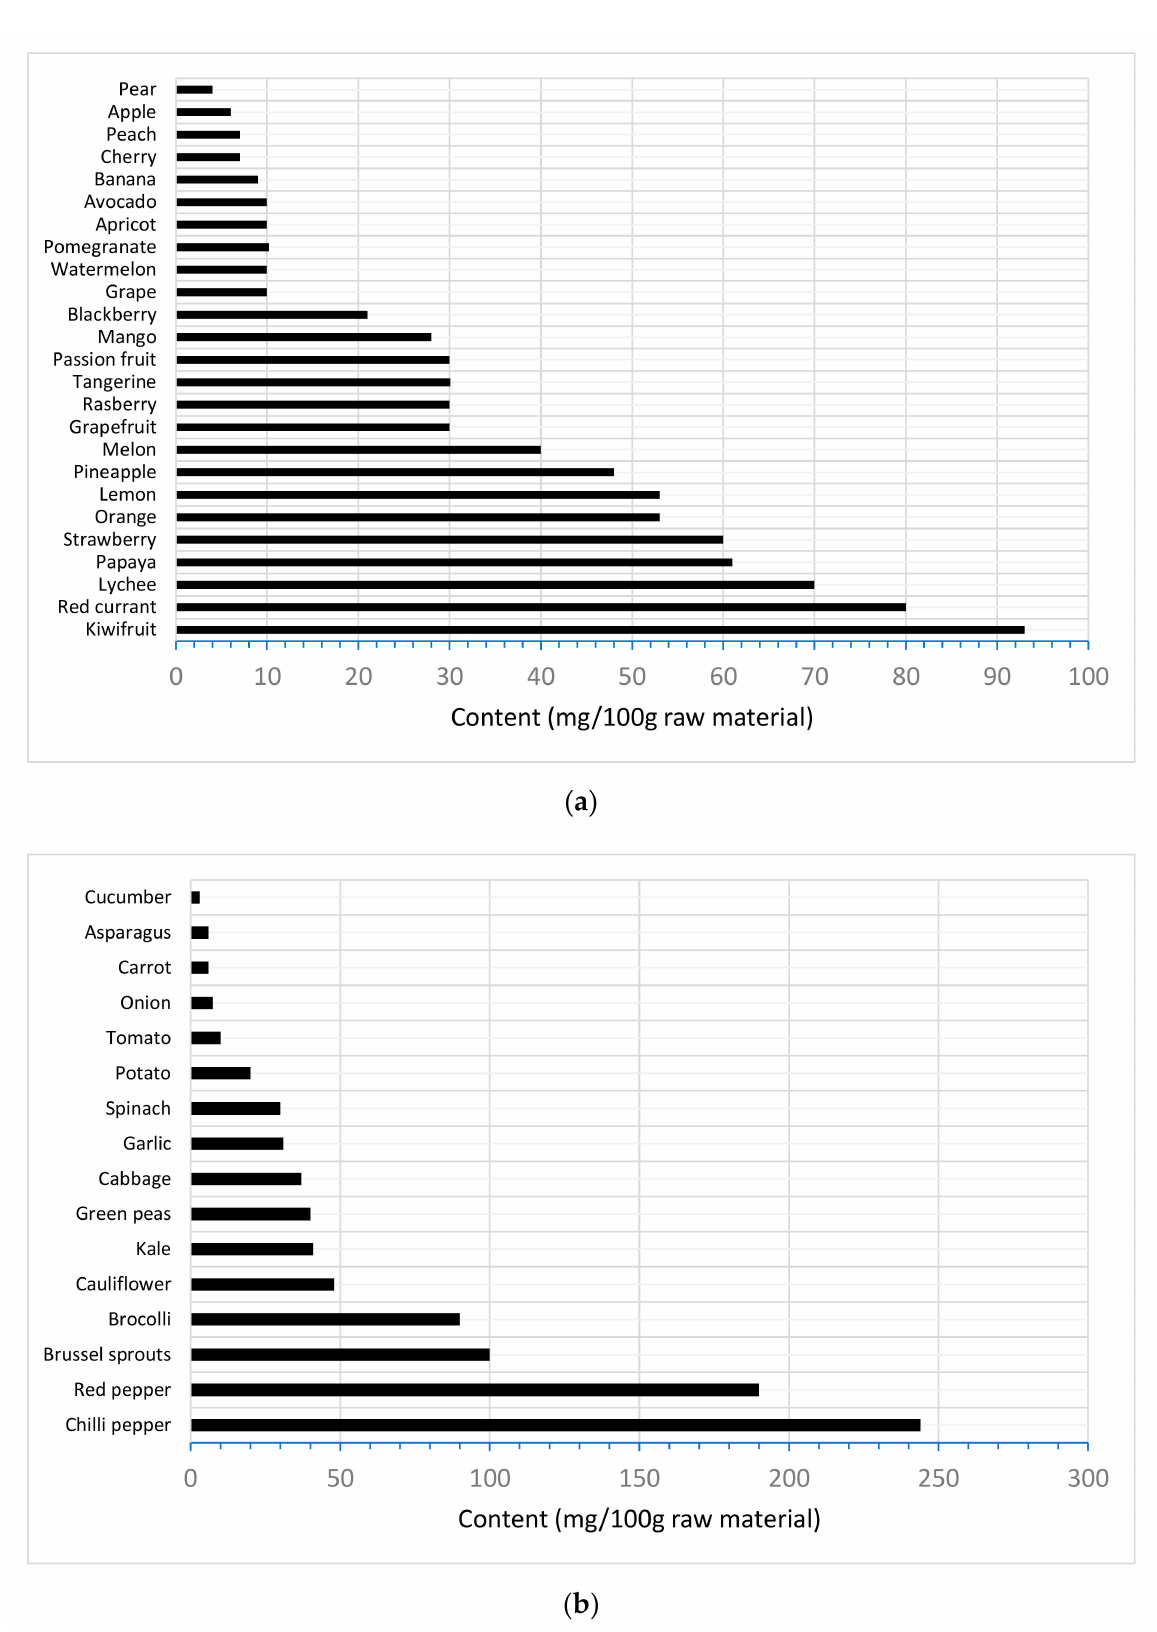
Figure 1. Mean content of Vitamin C in ( a ) fruits and ( b ) vegetables